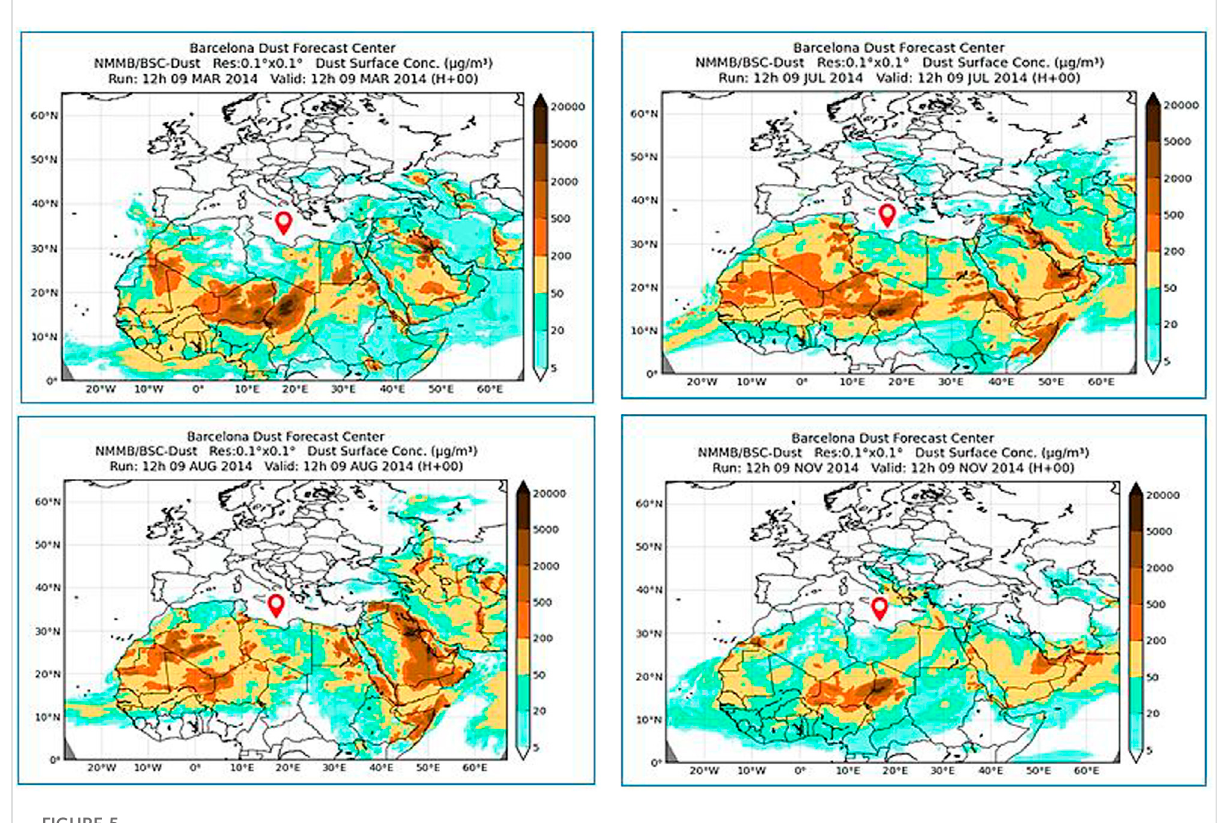
Daily dust surface concentrations (µg m − 3 ) over the selected